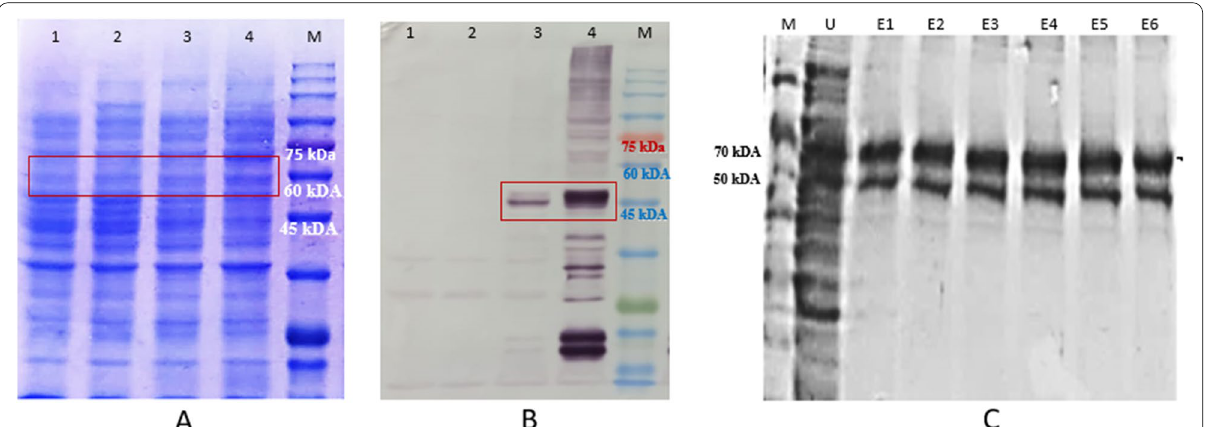
Fig. 6 Analysis of L1-HPV52 protein production in shake flask cultivation using A SDS-PAGE of crude samples and B western blot with anti-His-AP. Both Fig. 6A and B share the same protein arrangement; lane 1: BL21 DE3 no plasmid and uninduced; lane 2: BL21 (DE3 no plasmid and induced